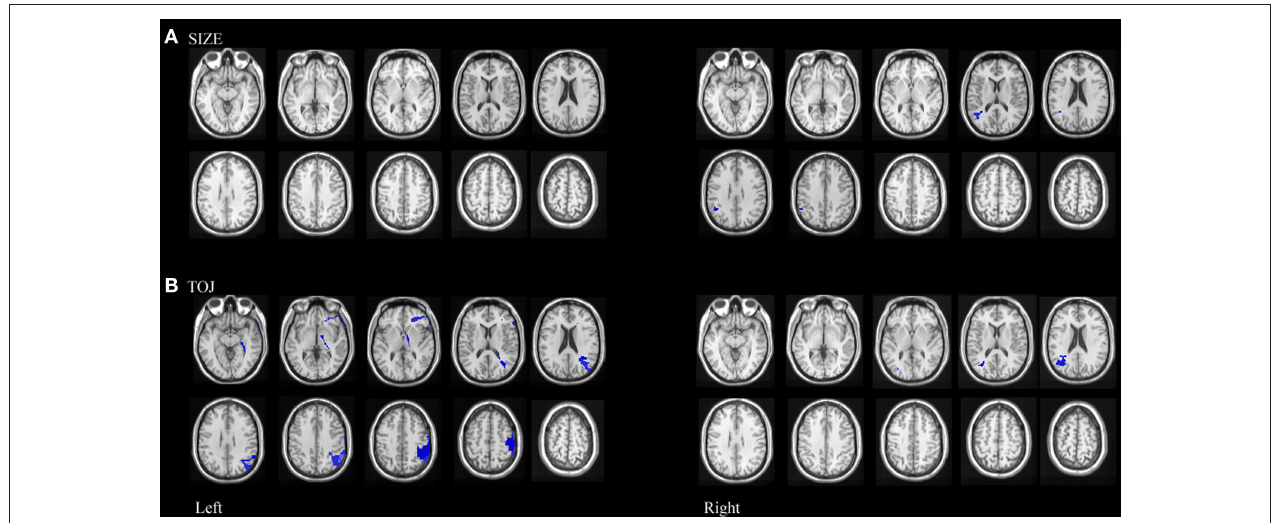
FiGure 6 | Statistical maps of neuroanatomic regions in which damage correlated significantly (using permutation statistics) with (A) residuals resulting from size performance regressed against TOJ performance, representing regions where lesions correlate with variance associated with size